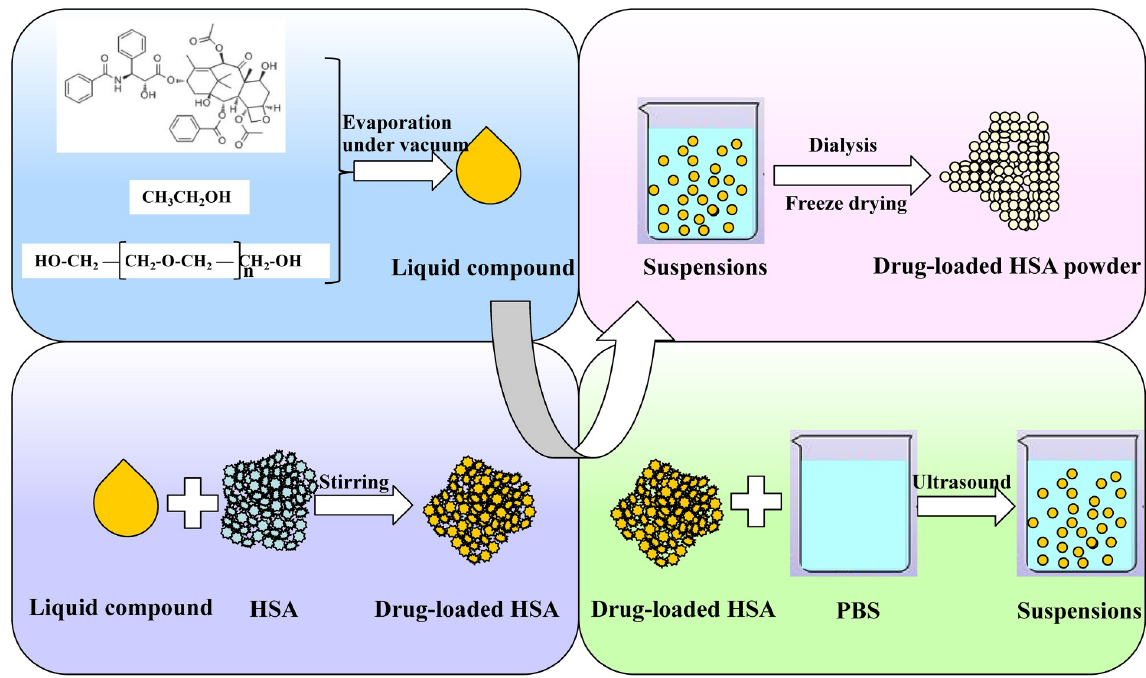
Fig 1. Schematic of nab paclitaxel preparation via a novel method. First, we dissolved paclitaxel and PEG in ethanol via ultrasound, and ethanol was subsequently evaporated under vacuum to obtain the liquid compound of paclitaxel and PEG. Then, paclitaxel was loaded in HSA powders by adding the liquid compound dropwise to HSA powder while stirring. Thereafter, the mixtures added to PBS under ultrasound, after which nab paclitaxel suspensions emerged. PEG and the residual ethanol in suspensions were removed by dialysis, and nab paclitaxel was finally obtained after freeze